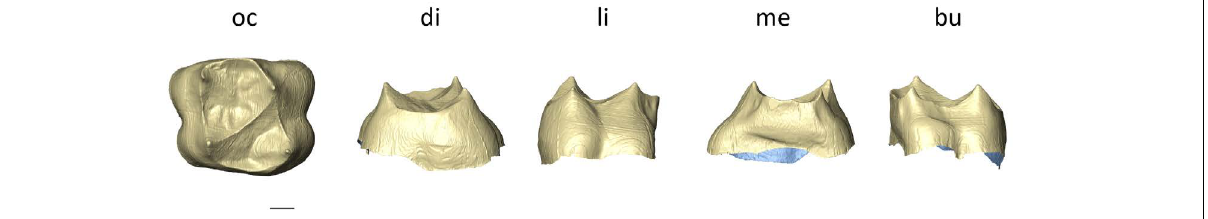
Figure 3: Virtual rendering of the enamel-dentine junction of StW 669 in occlusal (oc), distal (di), lingual (li), mesial (me) and buccal (bu)